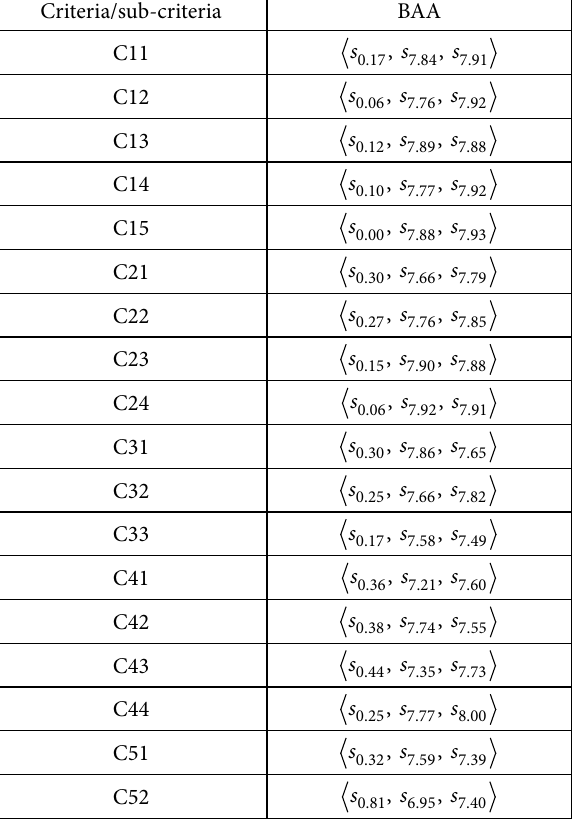
Criteria/sub-criteria